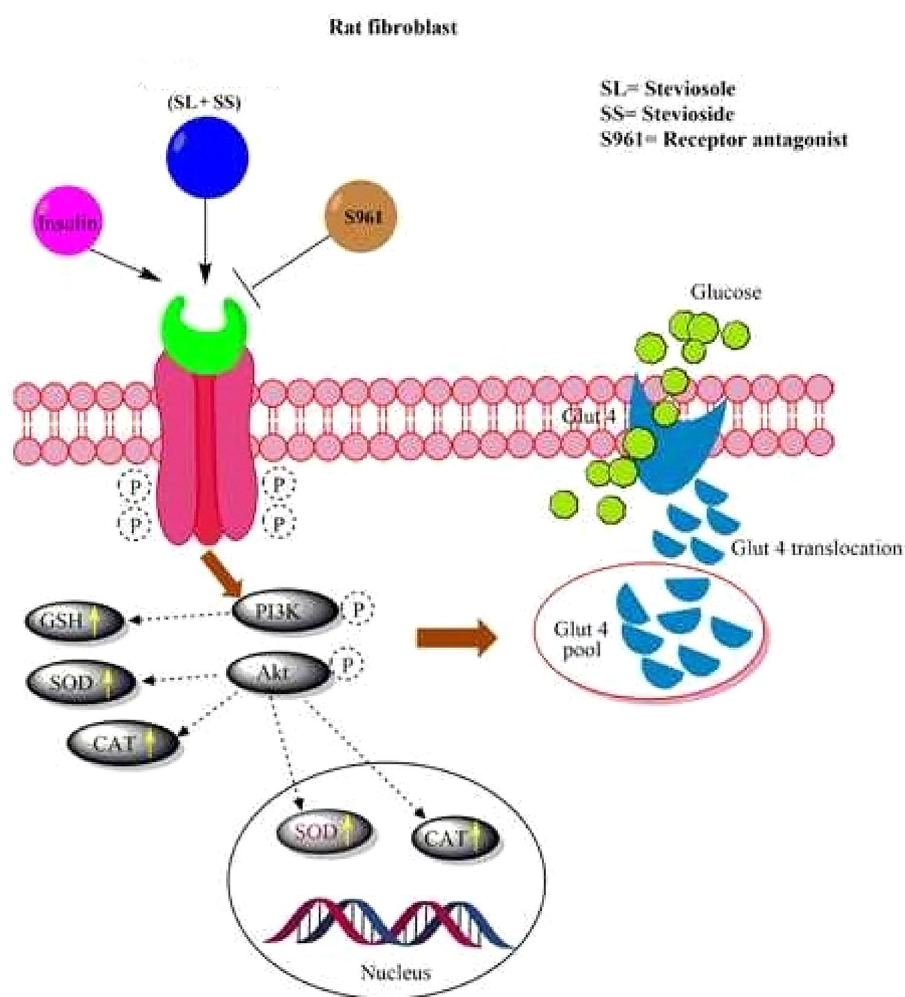
Fig. 1 Role of stevia glycosides as insulin-mimetic and anti- oxidant activities in neonatal rat fibroblast; S961; the insulin receptor antagonist; blocks the insulin and glycosides induced signals. Signals from the steviol glycoside lead to transloca- tion of Glut4 from intracellular pool to plasma membrane, thus allowing glucose which mimics the insulin activity. The expression and activity of both the antioxidant enzymes SOD and CAT is also enhanced due to the activation of the same pathway (dashed arrows). Furthermore, GSH levels are also increased with steviol